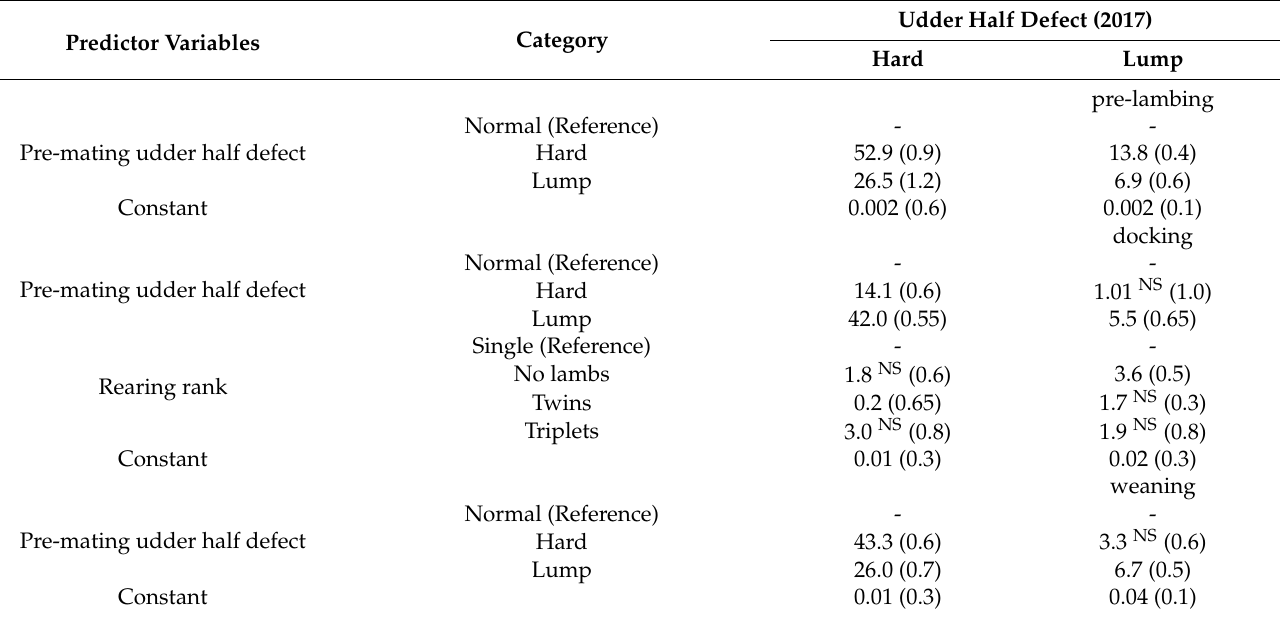
Table 1. Relative risk ratio (RRR ± standard error) of udder half defect category (normal, hard, or lump) at pre-lambing, docking, and weaning based on pre-mating udder half defect category from 1962 udder halves (from 981 non-dairy Romney ewes) in 2017 (Study A).